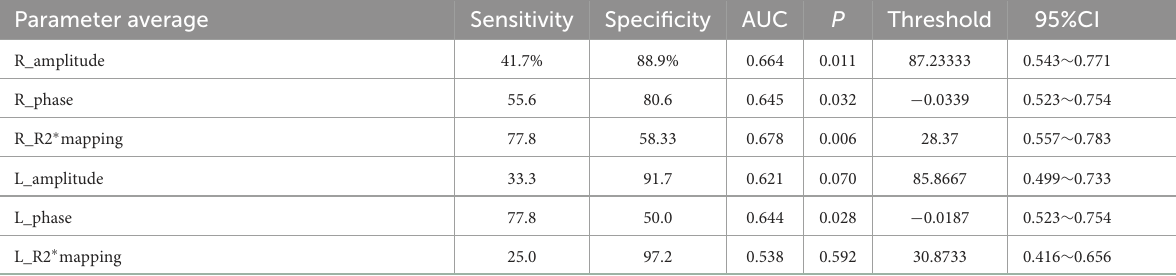
TABLE 3 Analysis of ROC curves for average value of each